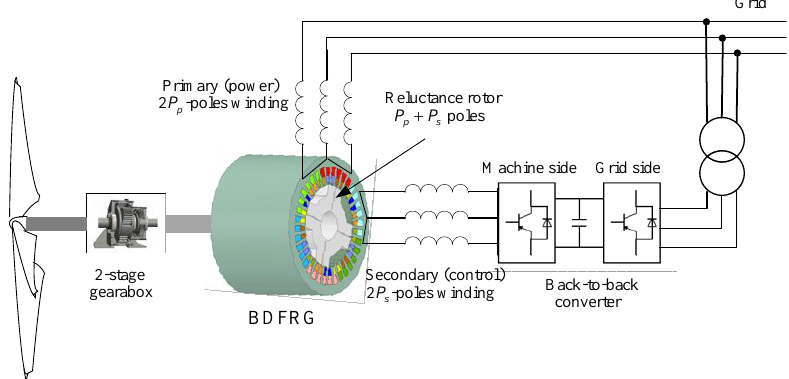
Figure 1. Conceptual diagram of the BDFRG-based wind energy conversion system.